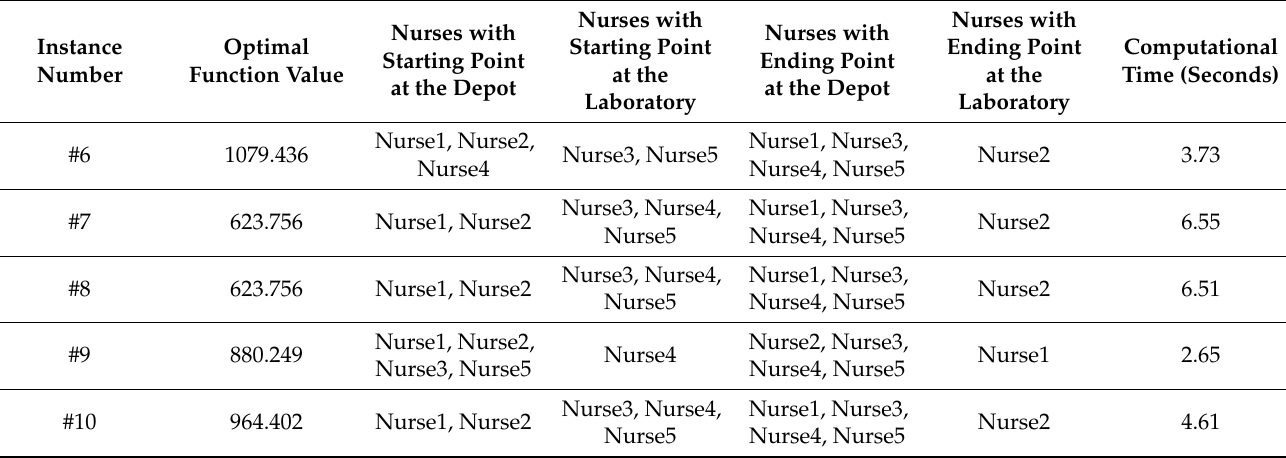
Table 6. The results for the medium instances.